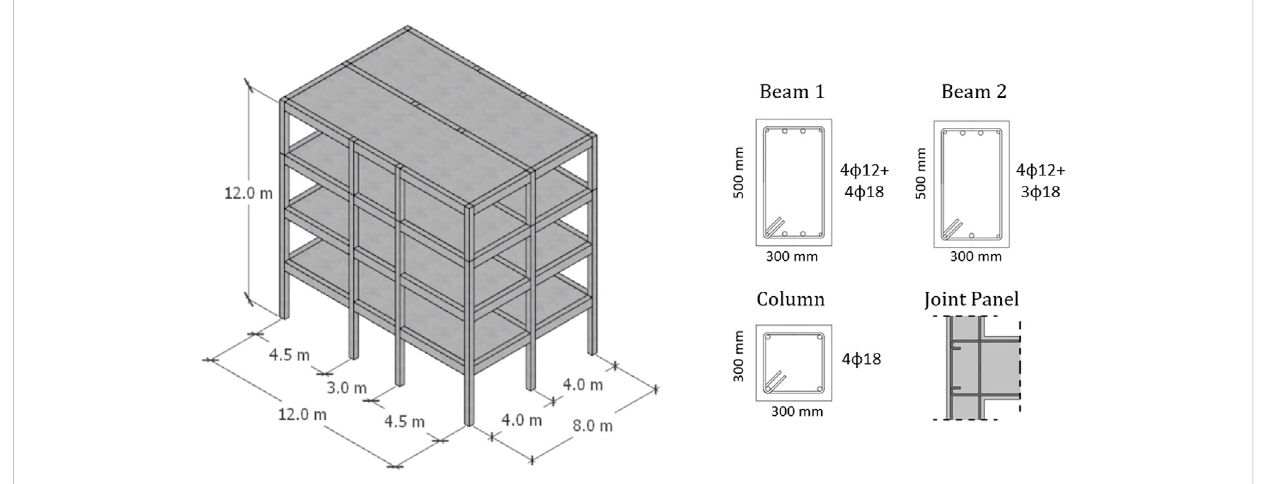
FIGURE 7 Global dimensions of the case-study building and geometrical details of RC members ( φ = diameter of reinforcement